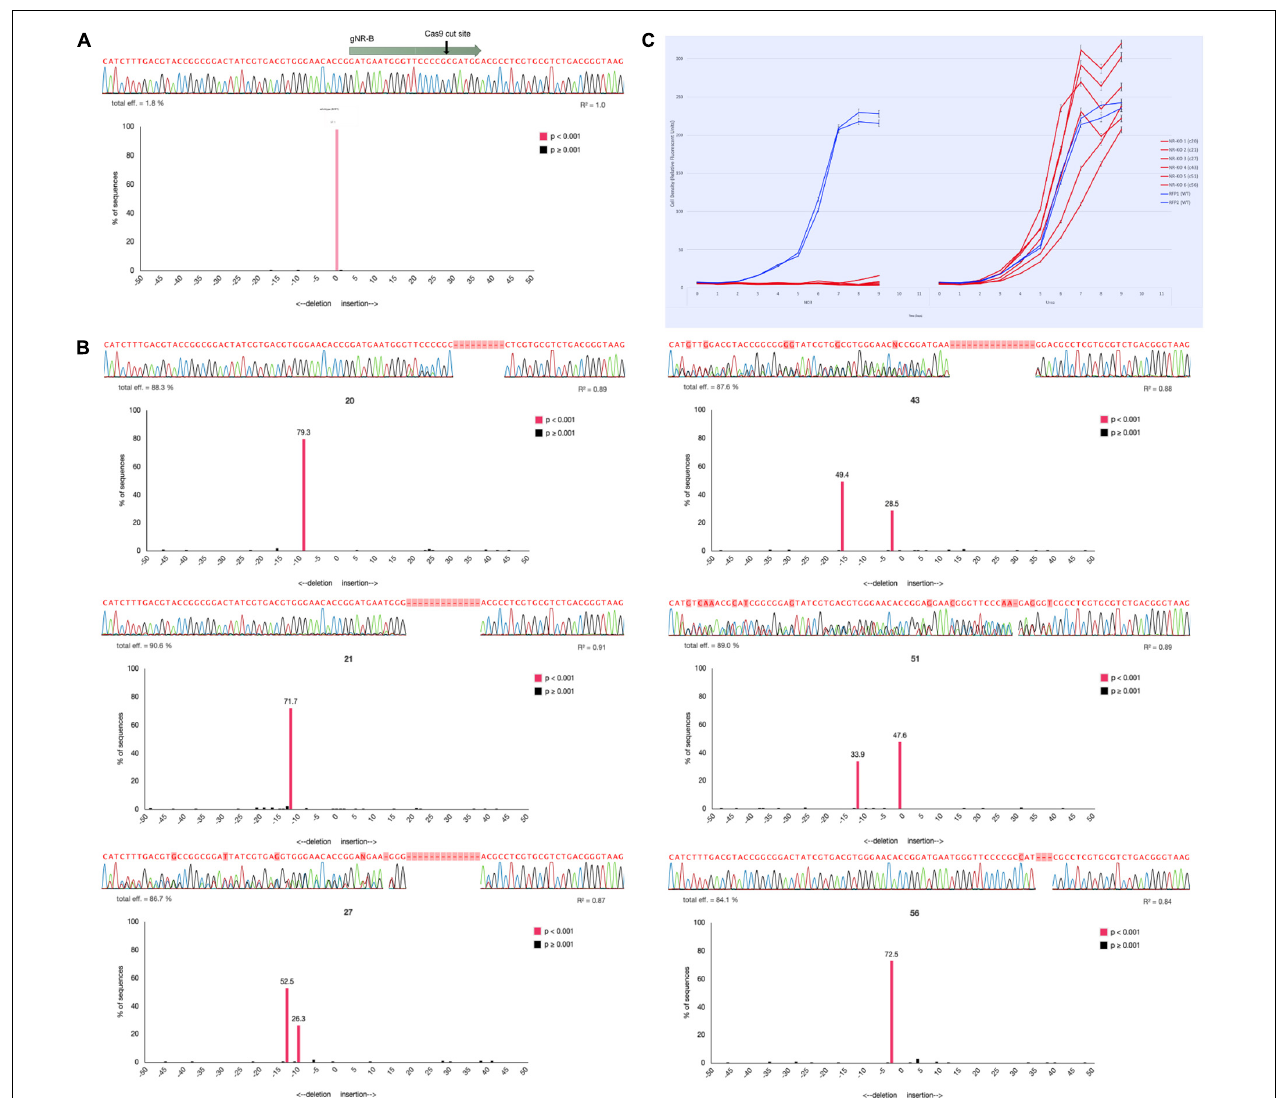
FIGURE 3 | Genotyping NR-KO mutant cell lines by colony sequencing and TIDE sequence analysis. (A) The sequencing alignment paired with a TIDE chart associated with a wild-type Phaeodactylum NR sequence. The gNR-B spacer and PAM are represented by the gray arrow and the Cas9 cut site by the black arrow. Below is the sequencing read, the associated electropherogram, and the TIDE result chart. The TIDE chart is a bar plot where the x -axis represents the predicted indel mutation (0, wild-type, negative values, nucleotide deletion; positive values, nucleotide insertion) and the y -axis represents the percentage the specific mutation is of the entire sequence. A bar shaded pink indicates a p -value < 0.001 for that predicted indel. Here, there is one pink bar at position “0” (wild-type) that represents 97.1% of the entire sequence (labeled above the bar). (B) Six NR-KO mutant cell line genotypes were assessed the same as wild-type. The wild-type sequencing read was used as a reference input for TIDE analysis to compare potential mutant sequence genotypes. NR-KO mutant genotyping was performed for all colonies using both manual sequencing curation and TIDE analysis ( Supplementary Table S2 ) and candidate NR-KO cell lines were chosen for phenotype analysis. Here, six NR-KO candidates and their associated genotyping results are shown. Cell lines 20, 21, and 56 display a single peak in the negative values that indicates a homozygous deletion genotype. Cell lines 27, 43, and 51 display two peaks in the negative values that indicate two deletions or a heterozygous deletion genotype. (C) The six candidate NR-KO cell lines were validated to have lost nitrate reductase function when grown in liquid medium supplemented with nitrate. Compared to growth on urea (left panel), the NR-KO mutant could not grow on nitrate (right panel). Two wild-type cell lines are blue and the six NR-KO cell lines are in red. All line were grown in technical